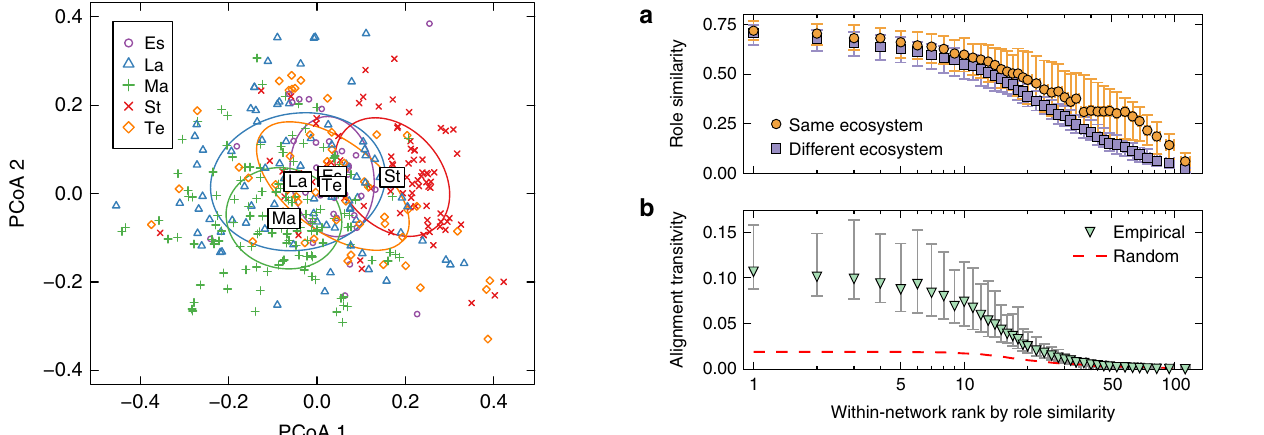
Algorithm tests sections of Supplementary Methods; Supple-